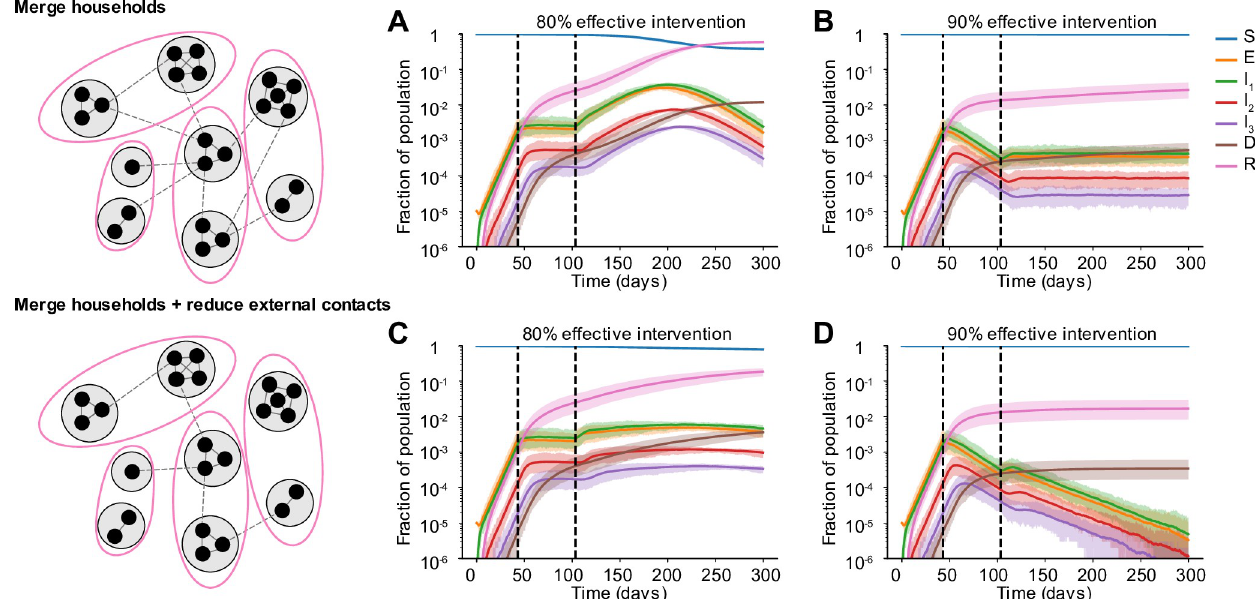
Fig 7. Effect of partially relaxing intervention by forming household bubbles. Some time after a social distancing intervention was implemented, each household merges with another random household. In each resulting two-household “bubble”, all individuals are connected to all other individuals. A)-D) Simulated time courses of infection before and after social distancing interventions (with 80% vs 90% intervention efficacy) and after partial-relaxation by household merging. Top row: External contacts of individuals were unchanged after two households were merged, such that overall number of contacts increased. Bottom row: External contacts for individuals were reduced after two households were merged, such that overall number of contacts remained unchanged. In all cases, intervention was started 43 days after the onset of the epidemic (first black dotted line) and was relaxed after two months (60 days, second black dotted